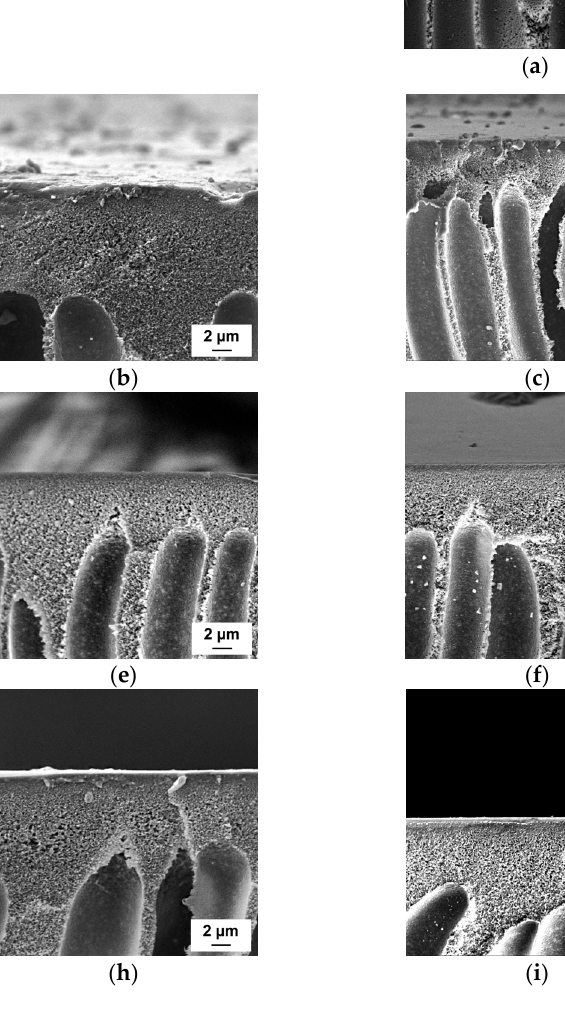
Figure 3. SEM micrographs of the cross-sections in the region near the skin layer of the reference PSF membrane ( a ) and membranes, modified by the introduction of PAA to the precipitation medium ( b – j ): ( a ) PA-0; ( b ) PA-100-1.0; ( c ) PA-250-1.0; ( d ) PA-450-1.0; ( e ) PA-100-1.5; ( f ) PA-250-1.5; ( g ) PA-450-1.5; ( h ) PA-100-2.0; ( i ) PA-250-2.0; and ( j ) PA-450-2.0. It was revealed that pore size and porosity significantly go down with a rise in PAA molecular weight and concentration (Figure 4). The pore size of membranes modified with PAA with molecular weights of 250,000 and 450,000 is so small that the pores cannot be detected at the studied magnification of the instrument. This trend is due to the rise in viscosity of precipitation media, which results in a decline in the rate of phase separation. Thus, an increase in the molecular weight of PAA yields an increase in the thickness and density of the skin layer and transitional layer and a decrease in the pore size of the selective layer, which is attributed to the decline in the rate of “solvent-non-solvent” exchange due to the rise in the viscosity of the coagulation